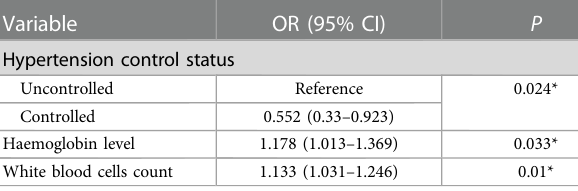
TABLE 4 Multivariate analysis of the variables associated with lipid control.